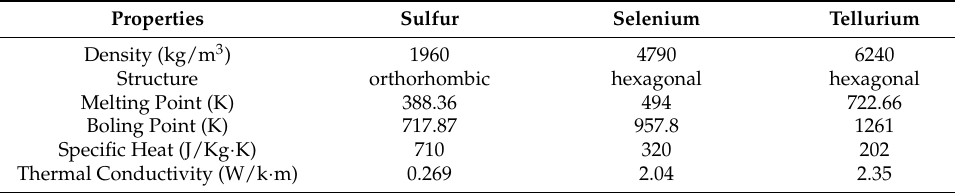
Table 2. Properties of some elements from group 16 of the periodic